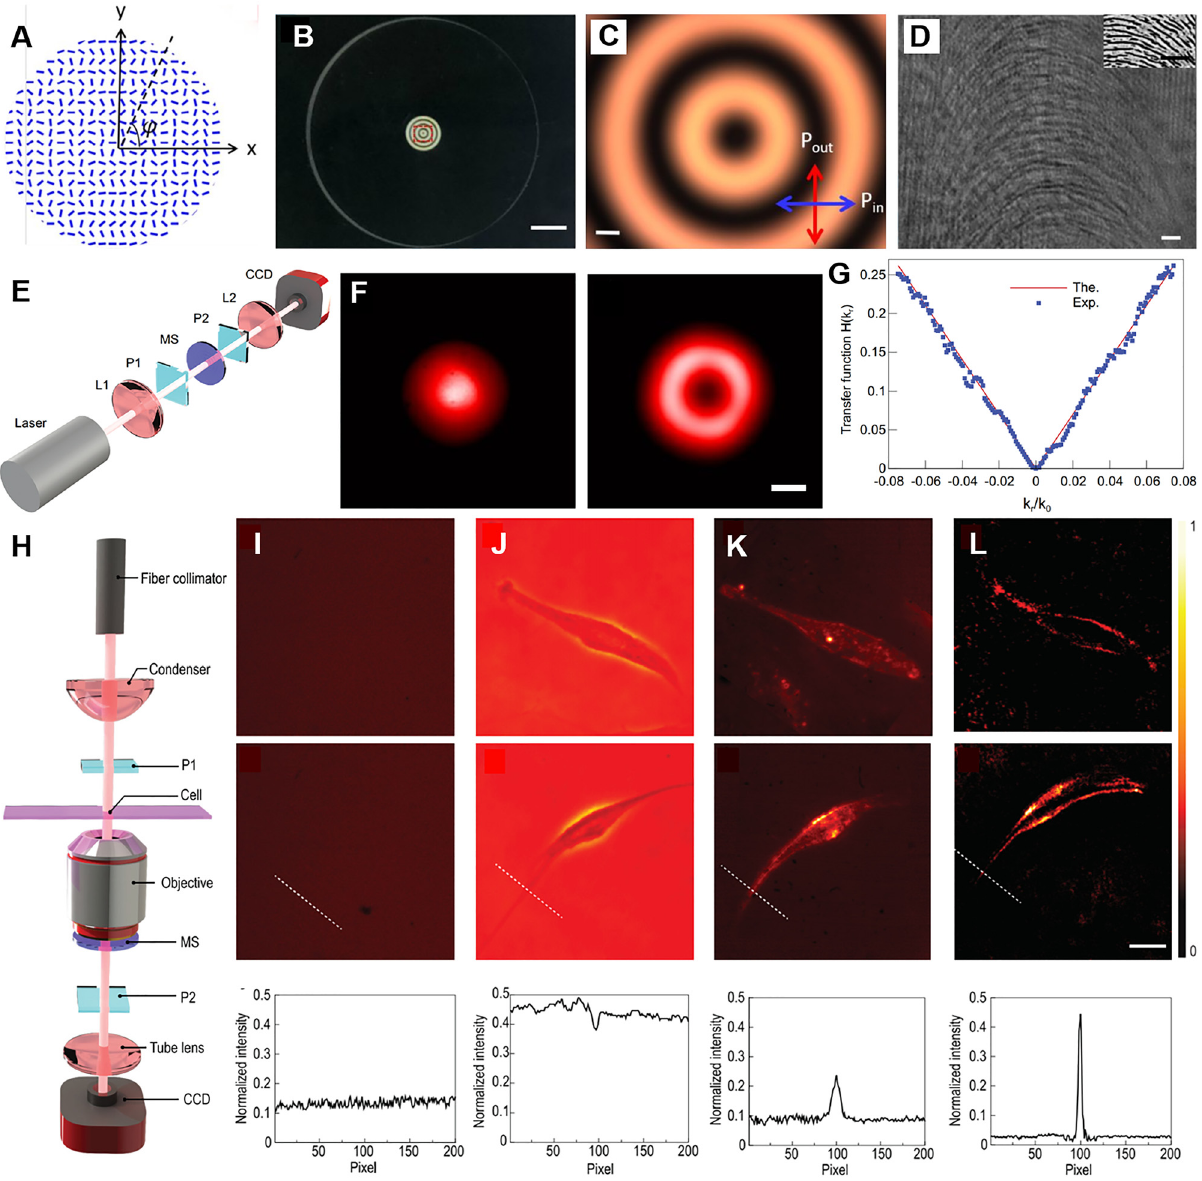
Figure 11: Two-dimensional optical spatial differentiation and high-contrast imaging based on PB phase metasurface [133]. (A) Schematic of the optical slow axis distribution of the metasurface designed to realize the differential operation. (B) Polariscope image of the metasurface. Scale bar, 4 mm. (C) An enlarged image of the sample pattern area marked in (B), under cross-polarized light. Scale bar, 200 μ m. (D) showsthe fi ner structureof the metasurface. Whitescale bar, 3 μ m.Inset is top view of SEM. Black scale bar, 1 µm.(E) Experiment setup for measurement of the spatial transfer function: L, lens, focal length 25 mm; P1 and P2, a pair of crossed polarizers; MS, metasurface, period 1000 μ m; CCD, charge couple device. (F) The experimental result without and with the spatial differentiator, respectively. Scale bar, 500 μ m. (G) The theoretical and experimental 1D transfer functions along the radial direction. (H) Measurement setup for edge detection of a phase object. (I) – (L) Observation methods for transparent cells include bright fi eld (I), phase difference (J), dark fi eld (K), edge detection (L). The fi rst row, the examined human umbilical vein endothelial cells (HUVEC). The second row, the observed human bronchial epithelial cells (HBEC). Scale bar, 100 μ m. The third row is the horizontal intensity distribution along the white dashed